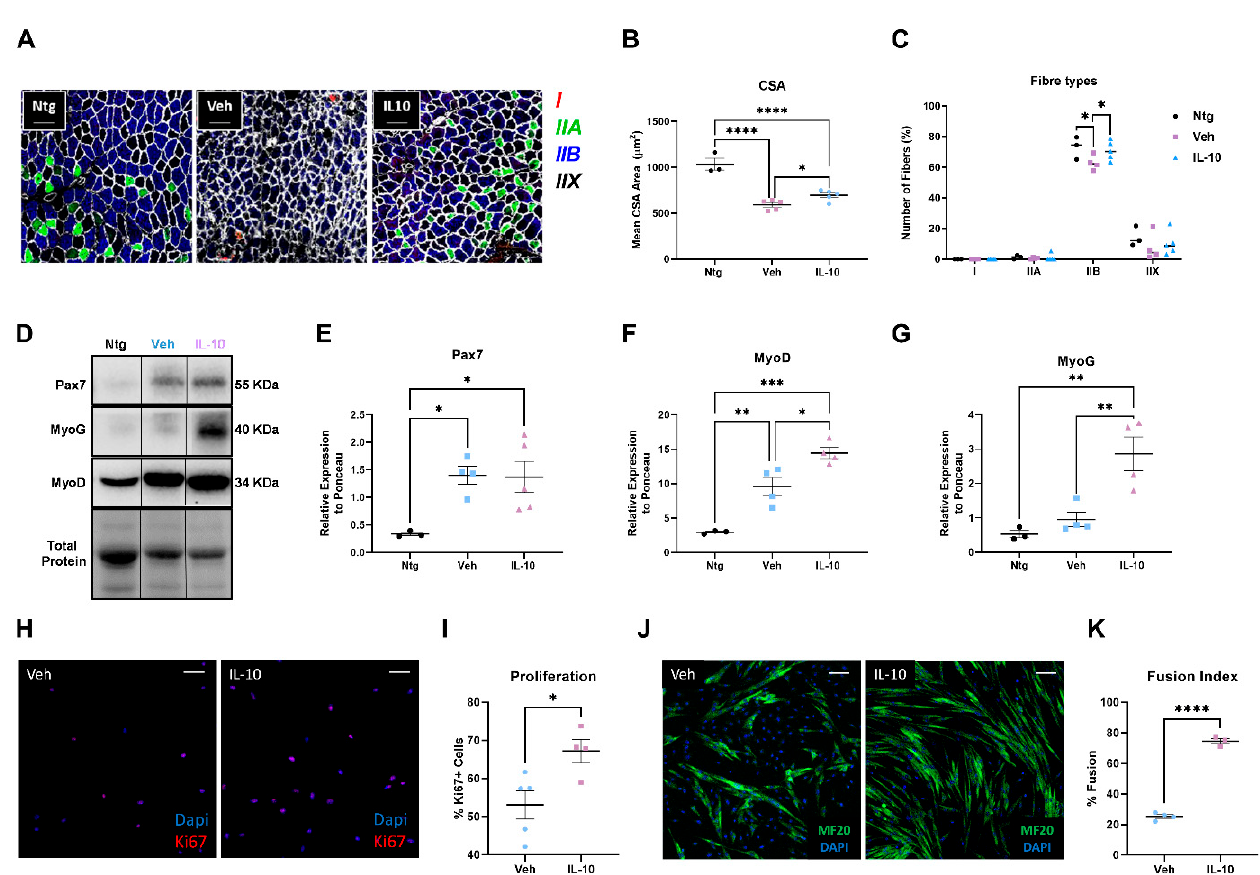
Figure 3. Intramuscular IL-10 administration preserves muscle architecture by eliciting satellite cell proliferation and differentiation in C57-SOD1G93A mice. ( A ) Representative confocal images showing the immunostaining of muscle fiber typing in TA muscle via myosin heavy chain (MHC) isoforms. Corresponding colour legend for fibers types: type I slow-twitch = red; type IIA fast-twitch oxidative = green; type IIX fast-twitch glycolytic = unstained (black); type IIB fast-twitch glycolytic = blue; laminin = white. Scale bar = 50 µ m. ( B , C ) Mean cross-sectional area (CSA) ( B ) and muscle fiber composition ( C ) in IL-10-treated C57-SOD1G93A mice compared to vehicle mice at 14 weeks of age. IL-10 increases the dimension of fibers, which is associated with a shift towards muscle fibers with large size. The data are presented as (mean ± SEM) of n = 4–5 independent experiments for each group. * p < 0.05, **** p < 0.001 by one-way ANOVA with Tukey’s